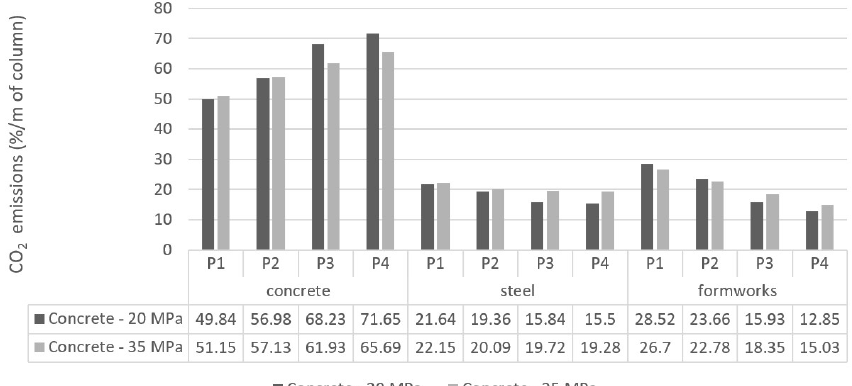
Figure 8. Percentage contributions of CO 2 emissions of materials for the optimized